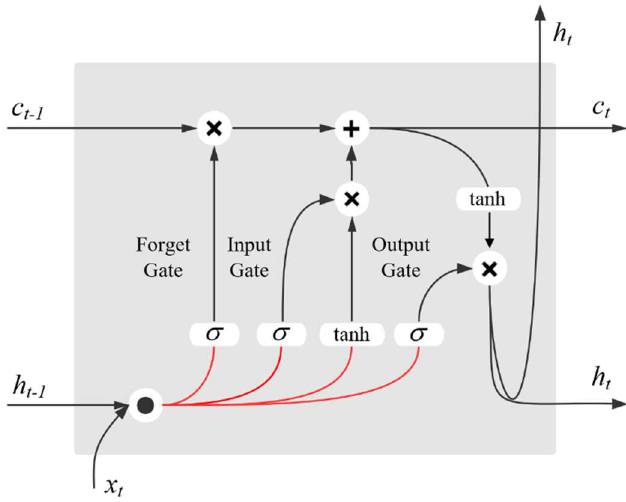
Figure 6. Schematic diagram of the memory cell.